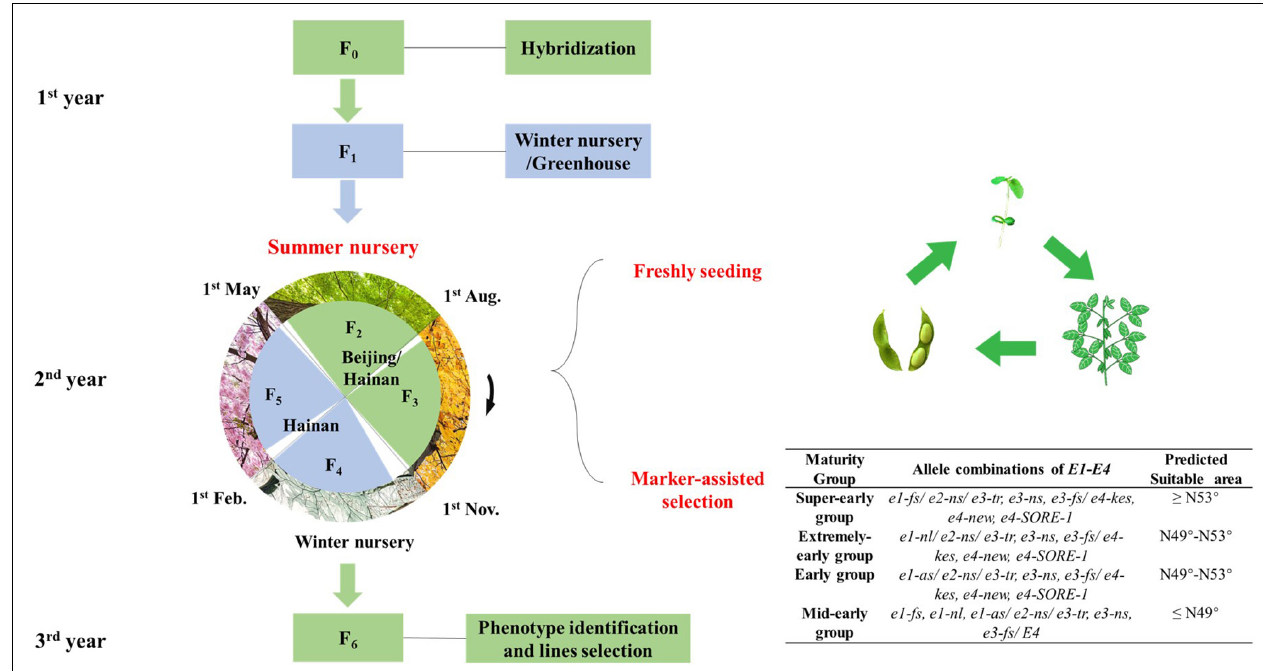
FIGURE 6 | Schematic representation of off-site speed breeding in soybean. The procedure of Speed Breeding System for soybeans from Northeastern Spring Planting Region and Yellow–Huai–Hai Valleys Summer Planting Region to fulfill four generations within 1 year (F 2 –F 5 ) and seven generations (F 0 –F 6 ) within 3